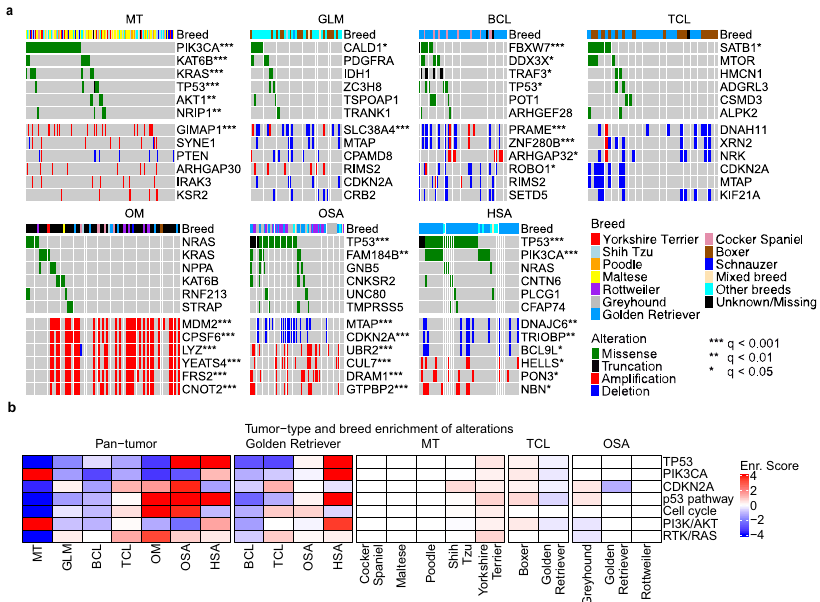
Fig. 3 Canine tumor alteration landscape, consisting of genes recurrently mutated and/or ampli fi ed/deleted, varies with tumor types but not with breeds in general. a Oncoprints indicate the top six most recurrently altered genes with nonsynonymous somatic base substitutions or small indels (top), or copy number alterations (CNAs) (bottom), in CDS regions in each tumor type indicated. Signi fi cant recurrence, identi fi ed by Fisher exact tests with multiple testing correction 60 , are denoted by “ * ” as shown. The breed of each animal is speci fi ed in the breed bar. b Enrichment scores of the most recurrently altered genes and pathways, obtained via Fisher exact test q -values (see “ Method ” ), in each tumor type of all breeds (left) and of Golden Retriever (middle), as well as in each breed with ≥ 10 dogs within a tumor type (right). Source data are provided as a Source Data fi